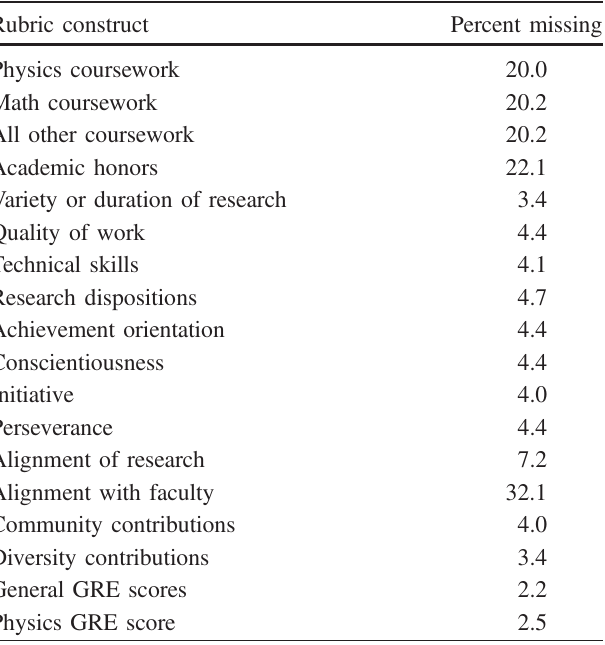
TABLE I. Percent of missing data by rubric construct. Rubric construct